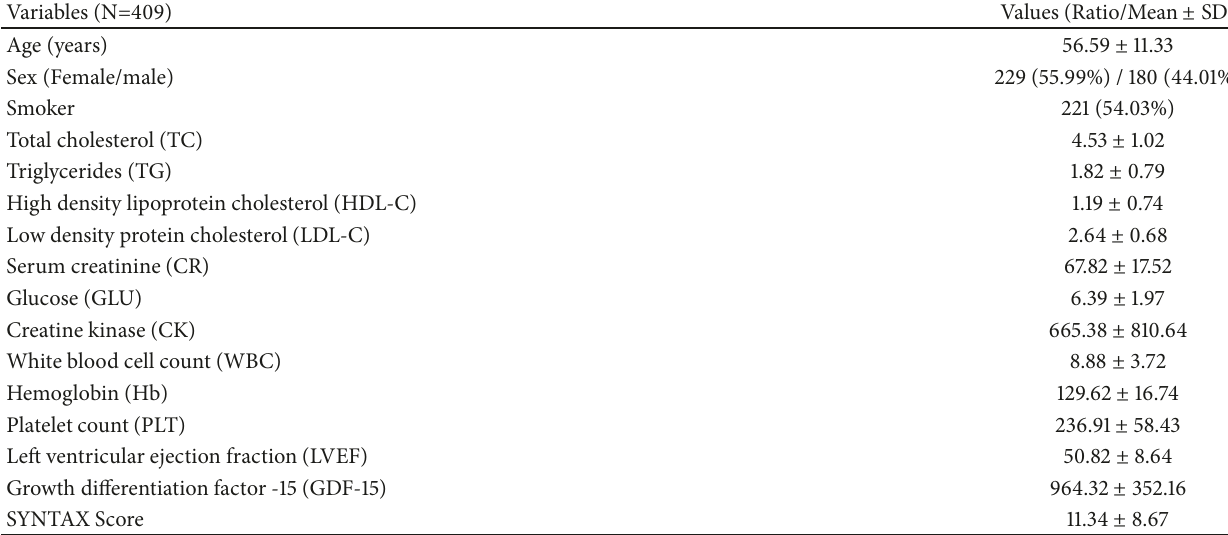
Table 1: Baseline level of 409 samples with acute coronary syndrome.